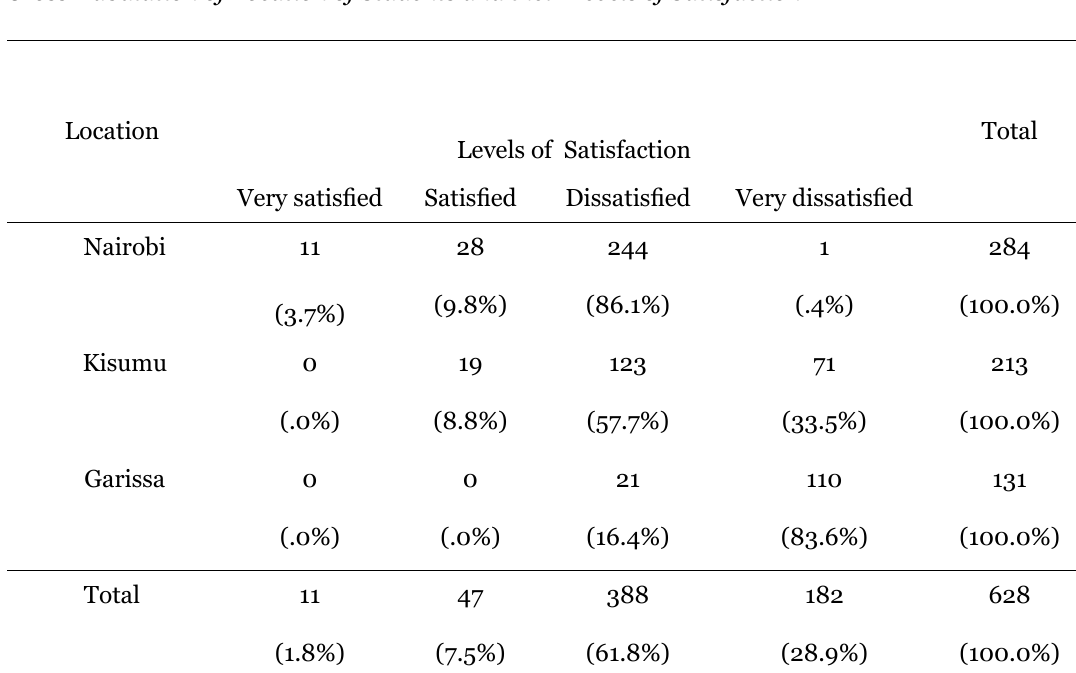
Table 4 Cross-Tabulation of Location of Students and their Levels of Satisfaction